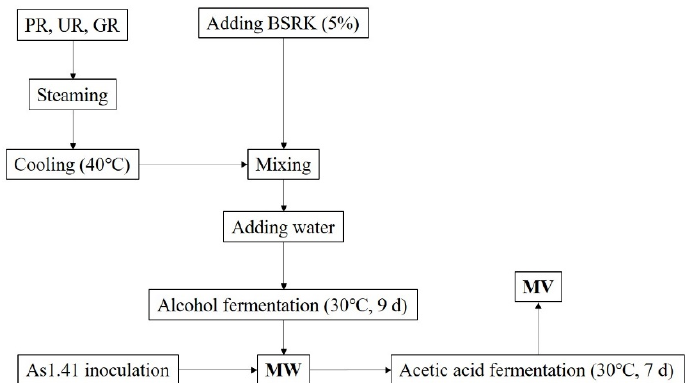
Figure 8. Schematic brewing process of Monascus vinegar. Abbreviations: PR-polished rice, UR-unhusked rice, GR-germinated rice, BSRK-black-skin-red-koji, MW- Monascus wine, MV- Monascus vinegar.